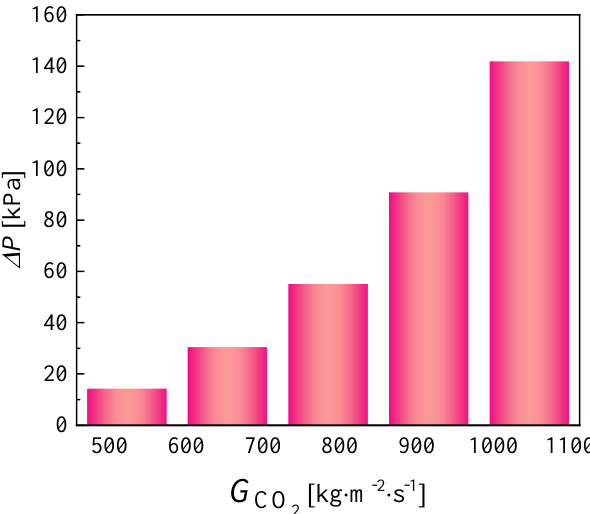
Figure 16. Variation in the pressure drop of CO 2 at different mass fluxes.